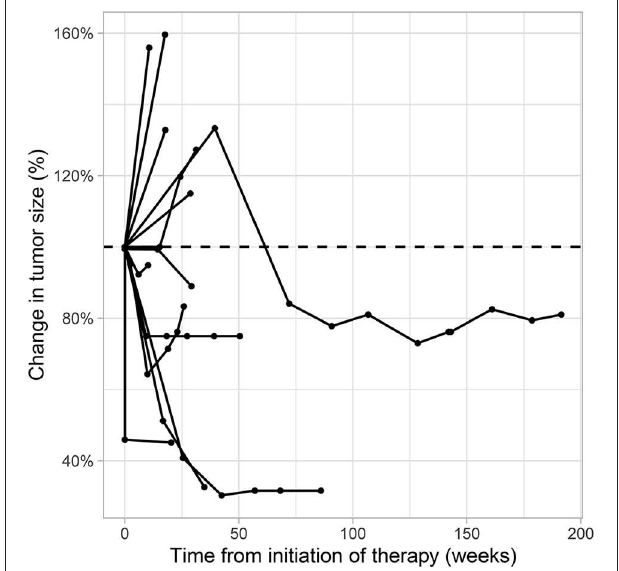
FIGURE 5 | Spider plot showing the percentage of target lesion tumor size change over time for each patient under second line therapy with checkpoint inhibitor monotherapy for metastatic urothelial carcinoma. Radiological data on tumor size change was available for 13 patients who had > 1 evaluable